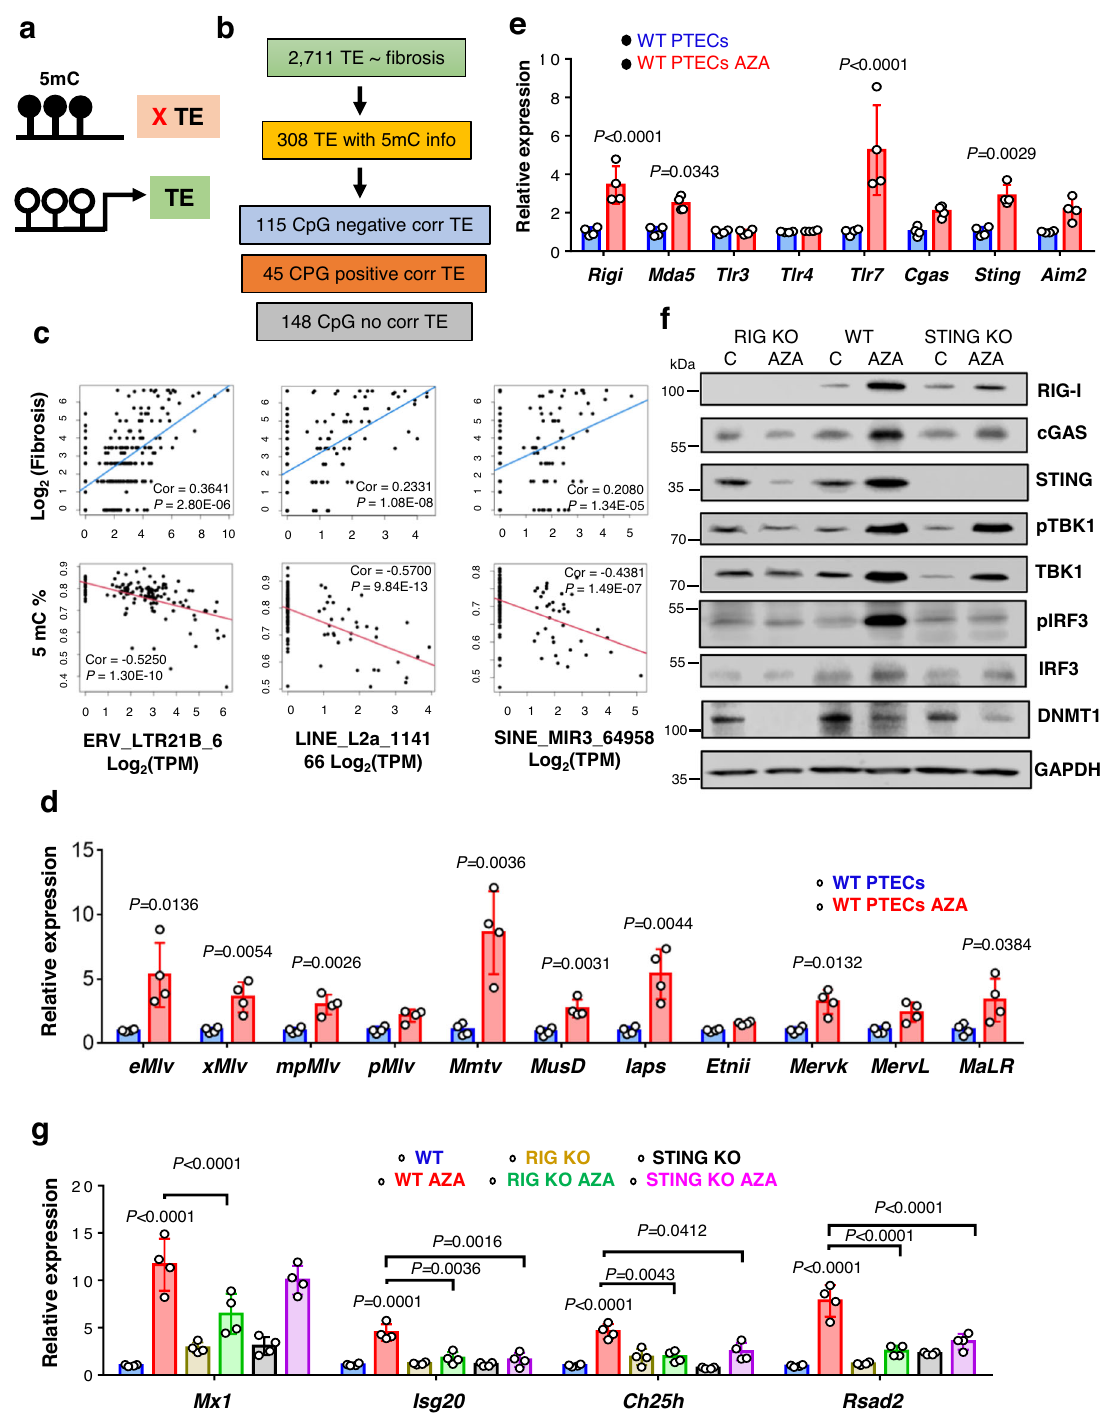
Fig. 5 | The relationship betweencytosine methylationand TE/ERV expression in human kidney samples. a Experimental hypothesis. b Number of analyzed CpGs overlapping differentially expressed TEs. c The relationship between endo- genous retrovirus K (ERVK), endogenous retrovirus 1 (ERV1), long interspersed nuclearelements(LINE)andshortinterspersednuclearelements(SINE)levels(log 2 TPM counts, x-axis),the degree of kidney fi brosis (log 2 fi brosis, y-axis),or cytosine methylation level (5mC beta, y-axis). d Relative expression levels of Class I ERVs ( eMlv, xMlv, mpMlv, pMlv , and Mmtv ), Class II ERVs ( MusD, Iaps, Etnii , and Mervk ), and Class III ERVs ( MervL and MaLR ) in WT PTECs treated with AZA (5-azacytidine 0.25 µ M) (red) or DMSO (blue) ( n =4 in each). e Relative expression of cytosolic RNA sensors ( Rigi, Mda5, Tlr3, Tlr4 , and Tlr7 ) and DNA sensors ( Cgas, Sting , and Aim2 ) in WT PTECstreated with AZAor DMSO ( n =4 ineach). Datawerepresented